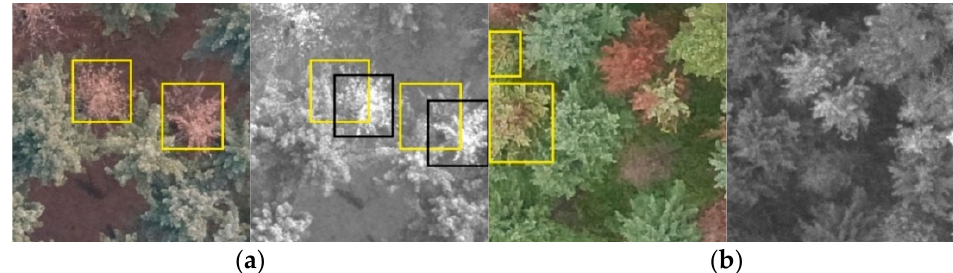
Figure 6. Mismatch of ground truth on visible and red-band images, where the yellow and black boxes are the ground truth in visible images and red-band images, respectively: ( a ) Position shifting of ground truth and ( b ) missing ground truth at the edge of red-band images.